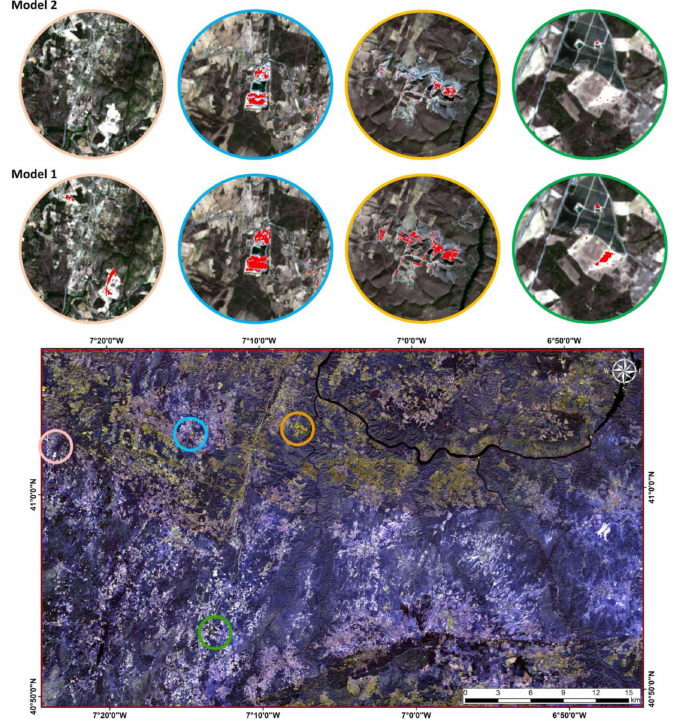
Figure 10. Reduction/elimination of misclassified pixels when comparing Remote Sensing Model 1 and